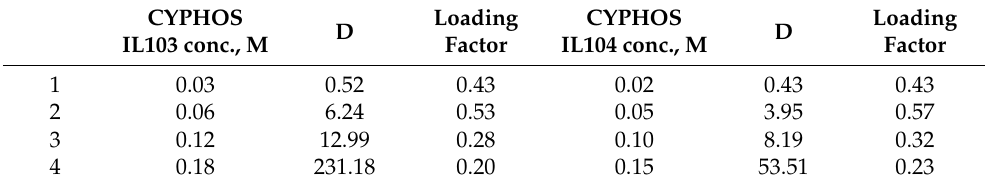
Table 2. Loading factor and distribution coefficient values obtained for C103 and C104 in heptane.